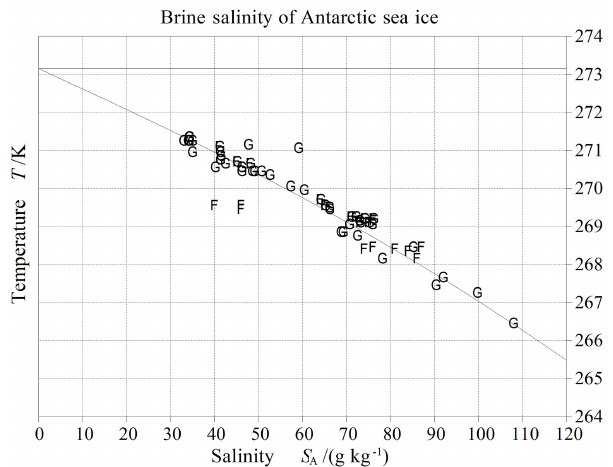
Figure 4. Brine salinity computed from TEOS-10 as a function of temperature at atmospheric pressure compared with measured re- sults for brine pockets of Antarctic sea ice. Symbol “F”: data of Fischer (2009); “G”: data of Gleitz et al. (1995). As these observa- tional data were not included in the construction of the 2008 Gibbs function, note that the curve is a theoretical prediction derived from the thermodynamic potentials of seawater and